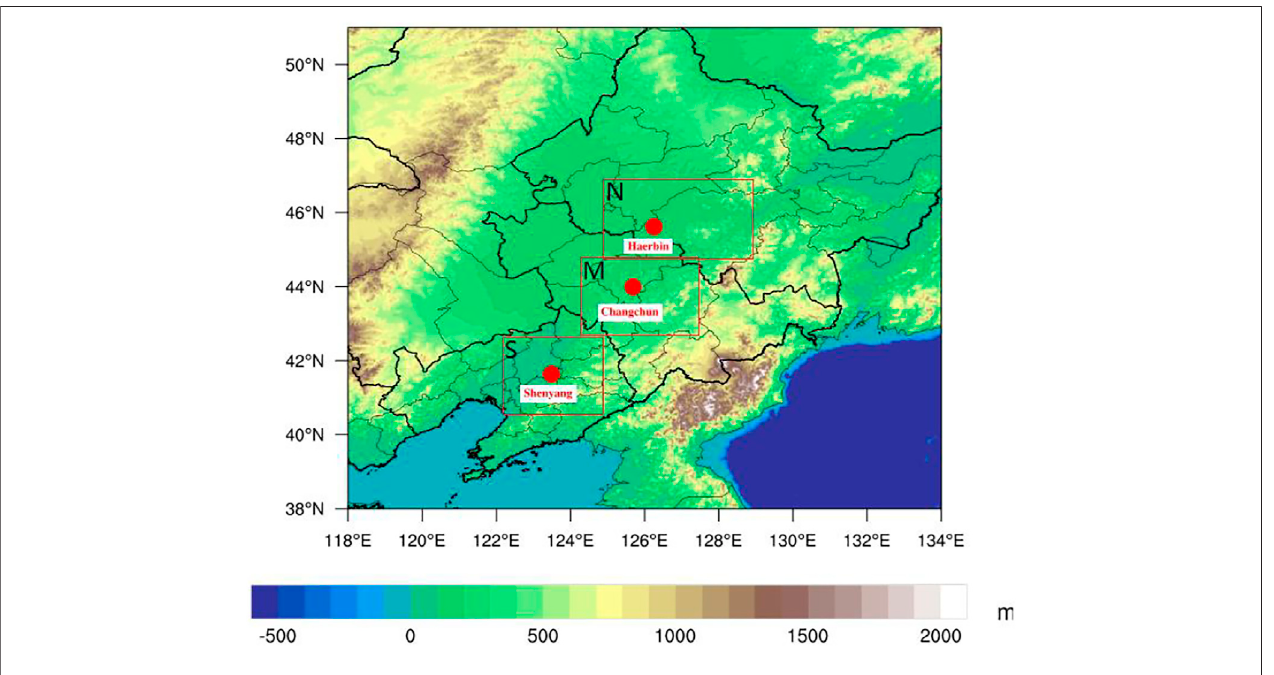
FIGURE 1 | Research area and surrounding